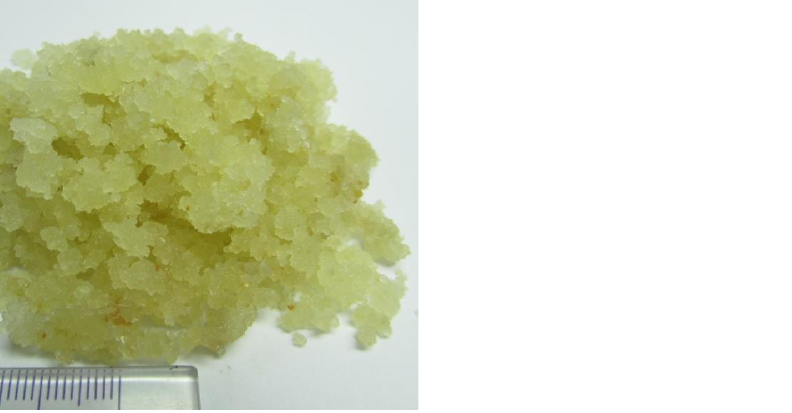
Figure 1. View of the Sr-L1 callus line of Scorzonera radiata at the stationary phase of growth, 30 days.